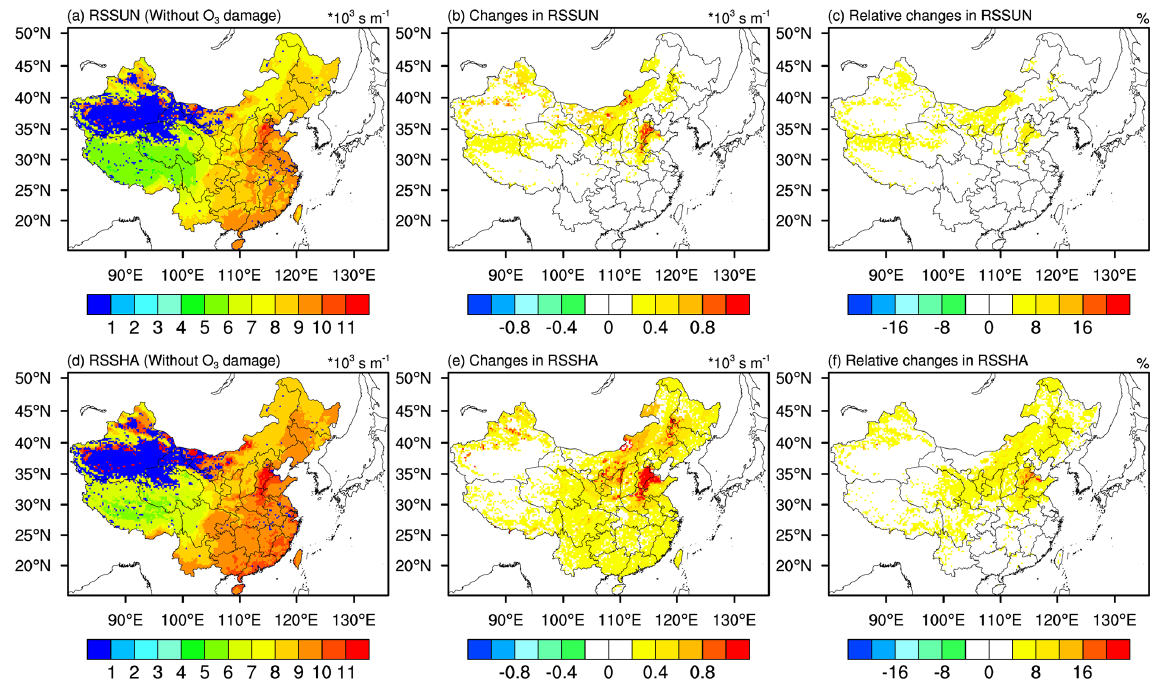
Figure 3. Spatial distribution of mean stomatal resistance in JJA of 2014–2017 for (a) sunlit leaves (RSSUN) and (d) shaded leaves (RSSHA) from the simu_withoutO 3 experiment. Absolute changes in (b) RSSUN and (e) RSSHA caused by O 3 damage. Relative changes in (c) RSSUN and (f) RSSHA caused by O 3 damage. Absolute changes are the RSSUN (RSSHA) from simu_withO 3 minus RSSUN (RSSHA) from simu_withoutO 3 . Relative changes are calculated by absolute changes over the RSSUN (RSSHA) from simu_withoutO 3